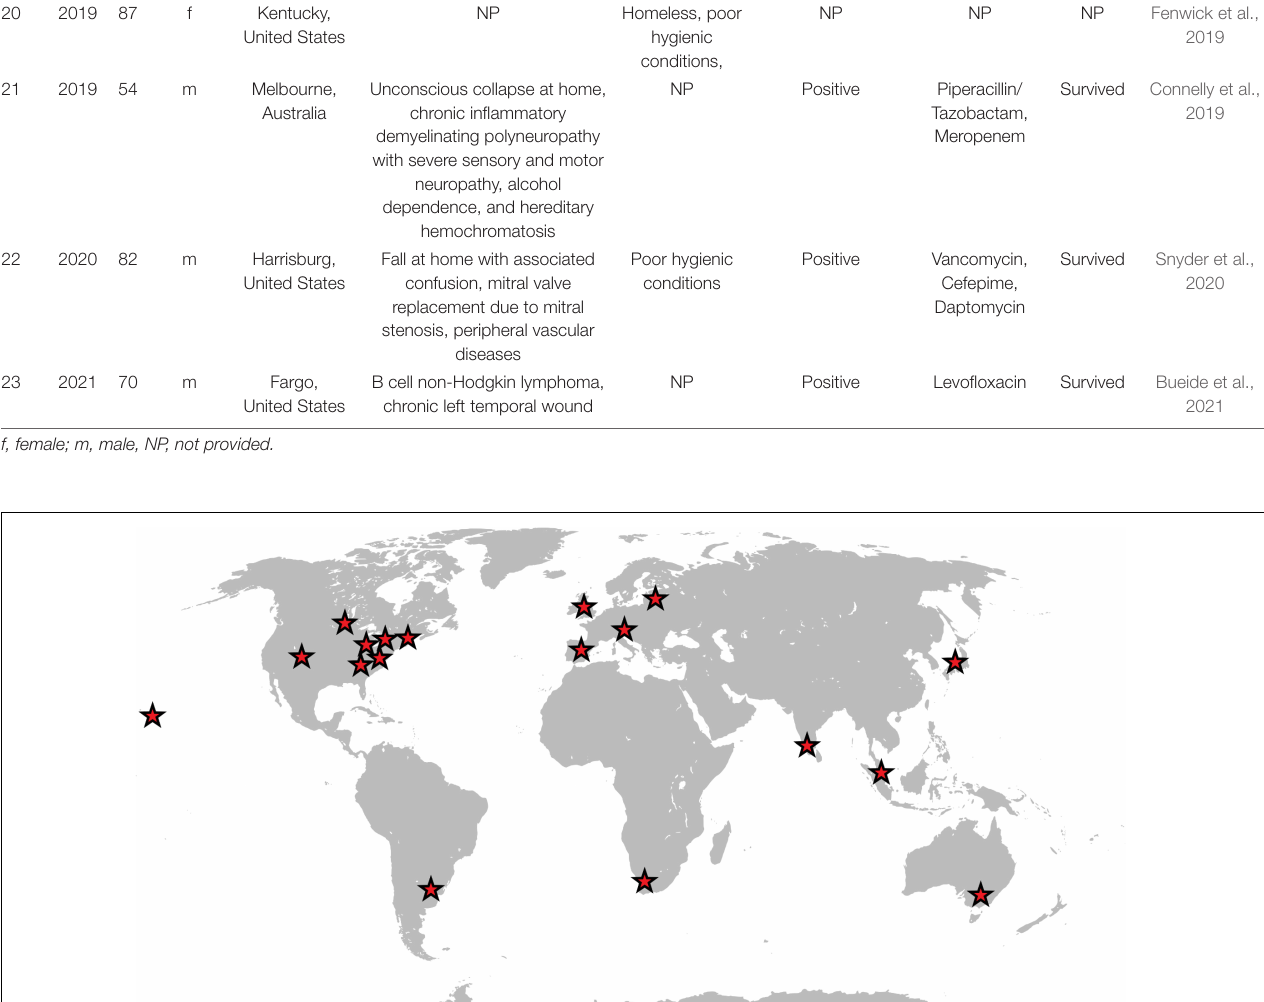
Frontiers in Microbiology |